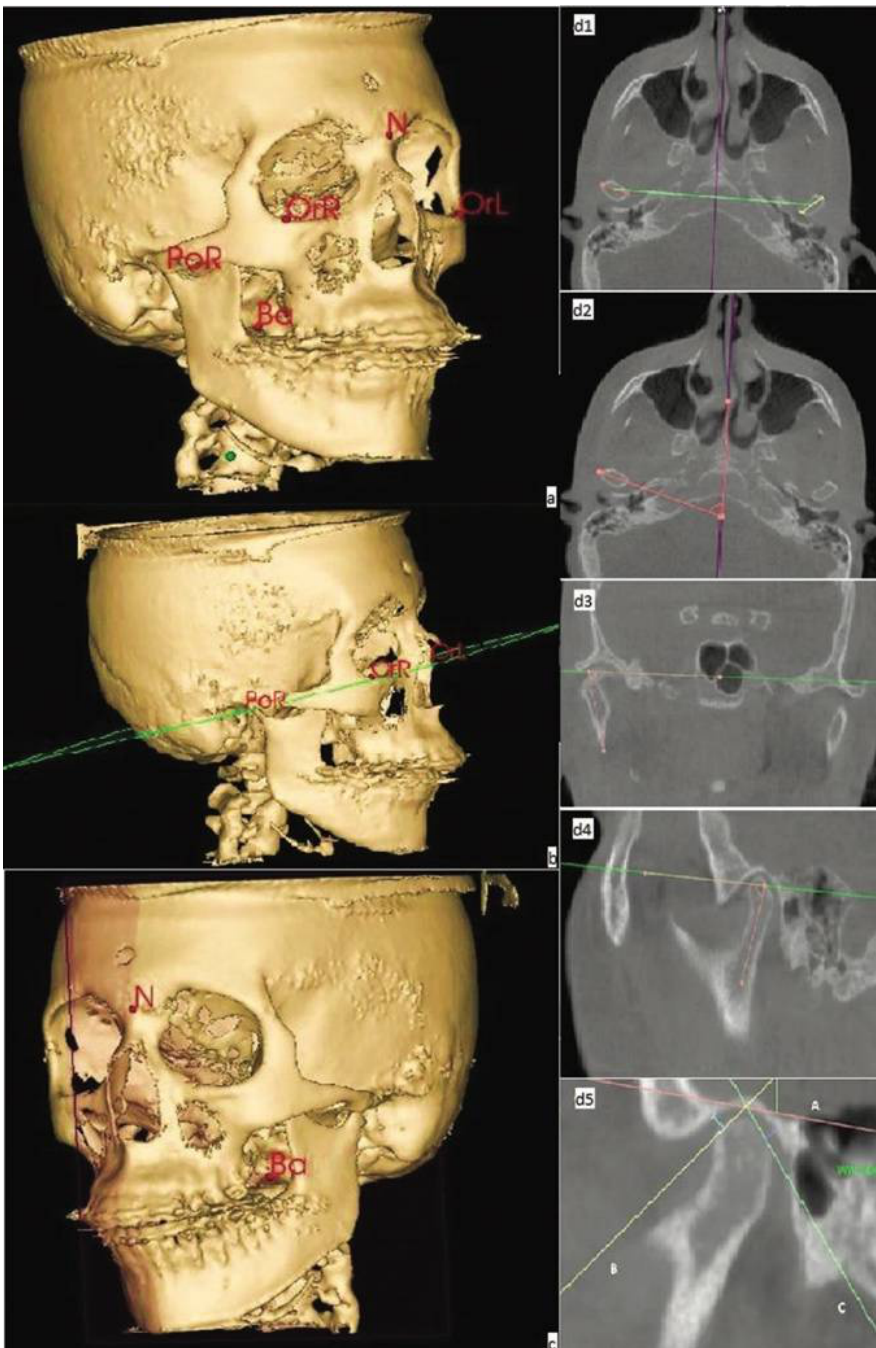
Figure 1. Three-dimensional cephalometry: Mean reference points ( A ); Frankfurt Horizontal Plane ( B ). Midsagittal plane ( C ). Intercondylar distance assessment ( d1 ). Condyle angle ( d2 , d3 ) and Condyle position in the sagittal plane ( d4 , d5 ). N – nasion; OrR - Orbital right; OrL – Orbital left; PoR – porion; Ba – basion.